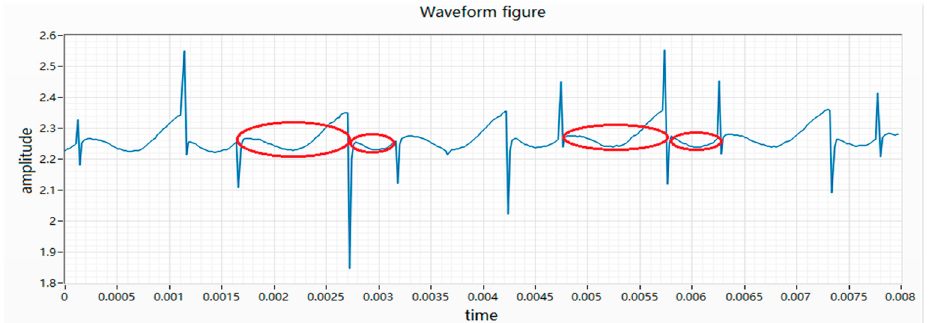
Figure 10. Waveform diagram of waveform length.